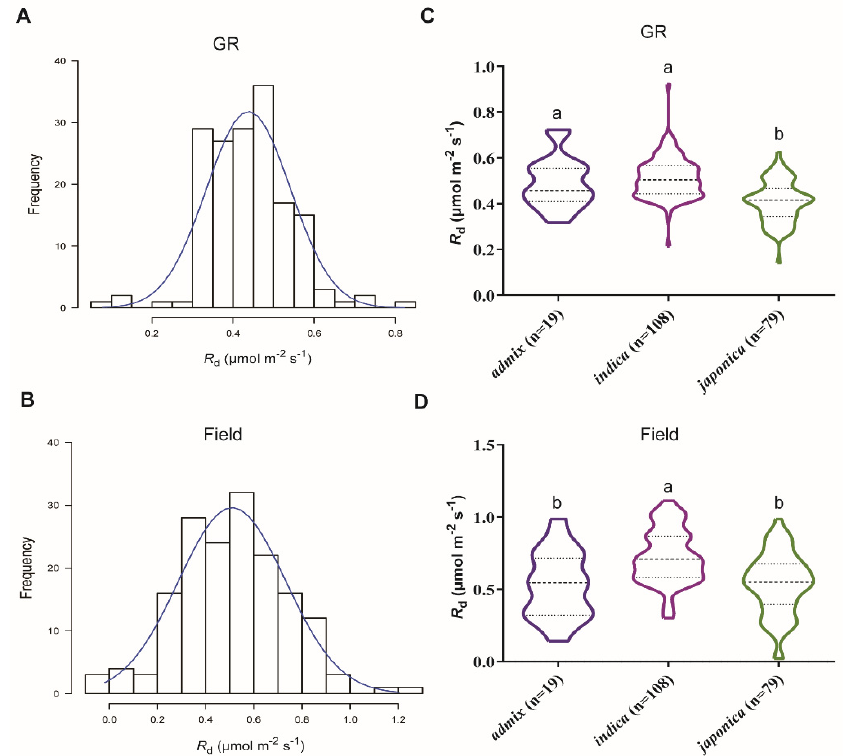
Figure 1. Natural variation of dark respiration ( R d ) in 206 rice lines in a global rice minicore diversity panel. ( A , B ) Histogram of R d under growth room (GR) and field conditions, respectively. ( C , D ) Frequency distribution of observed R d under GR and field, respectively. indica includes Australica (AUS) and indica (IND); while, japonica encompasses temperate japonica (TEJ), tropical japonica (TRJ) and aromatic (ARO). Admix represents a mixture of indica and japonica . Di ff erent letters are significantly di ff erent at 5% level among subpopulations with the Tukey test.